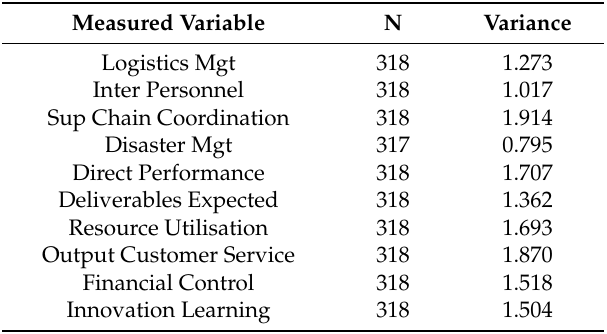
Table 4. Variance values (Source: Survey data).